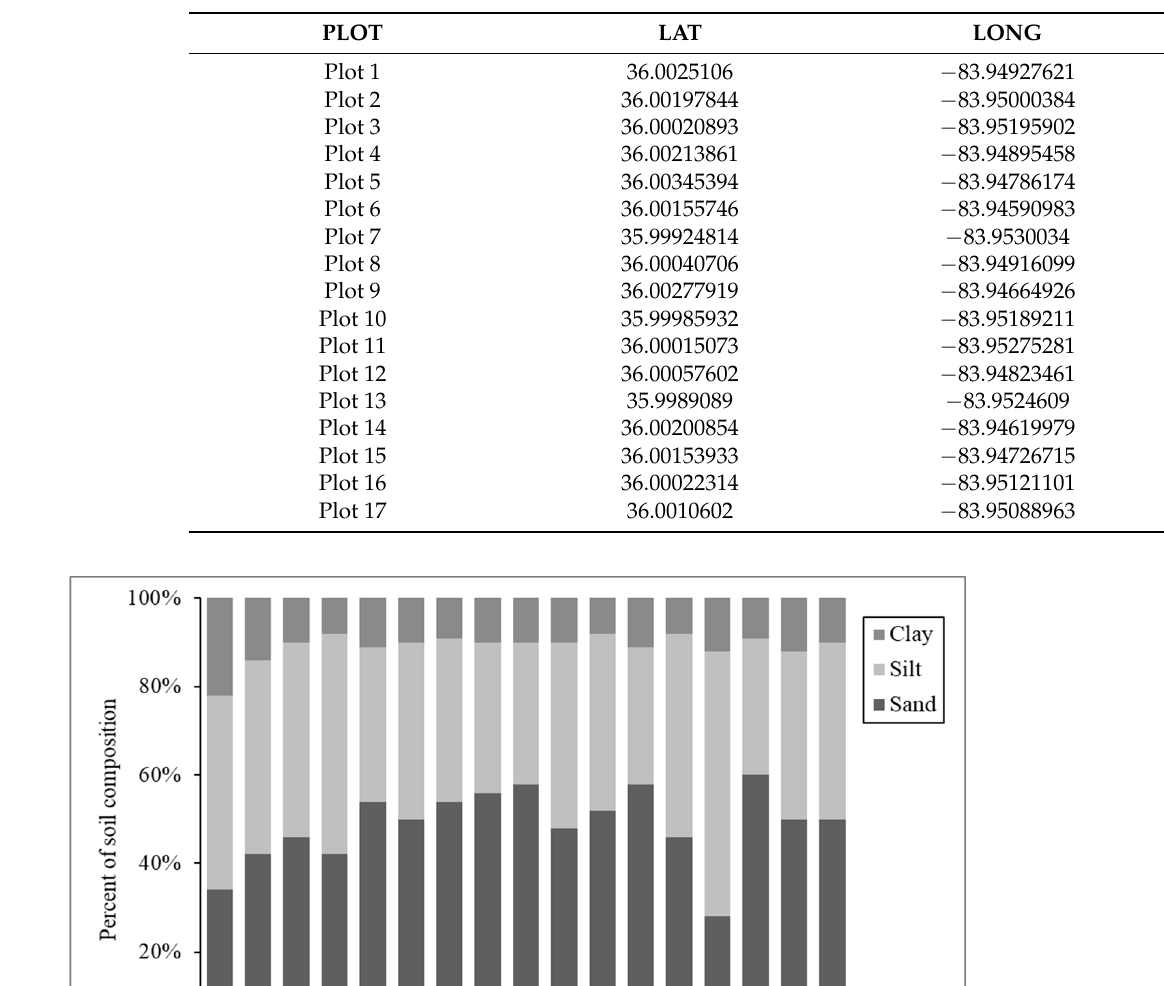
Table A2. Coordinates of 17 ecological sampling plots in this study.